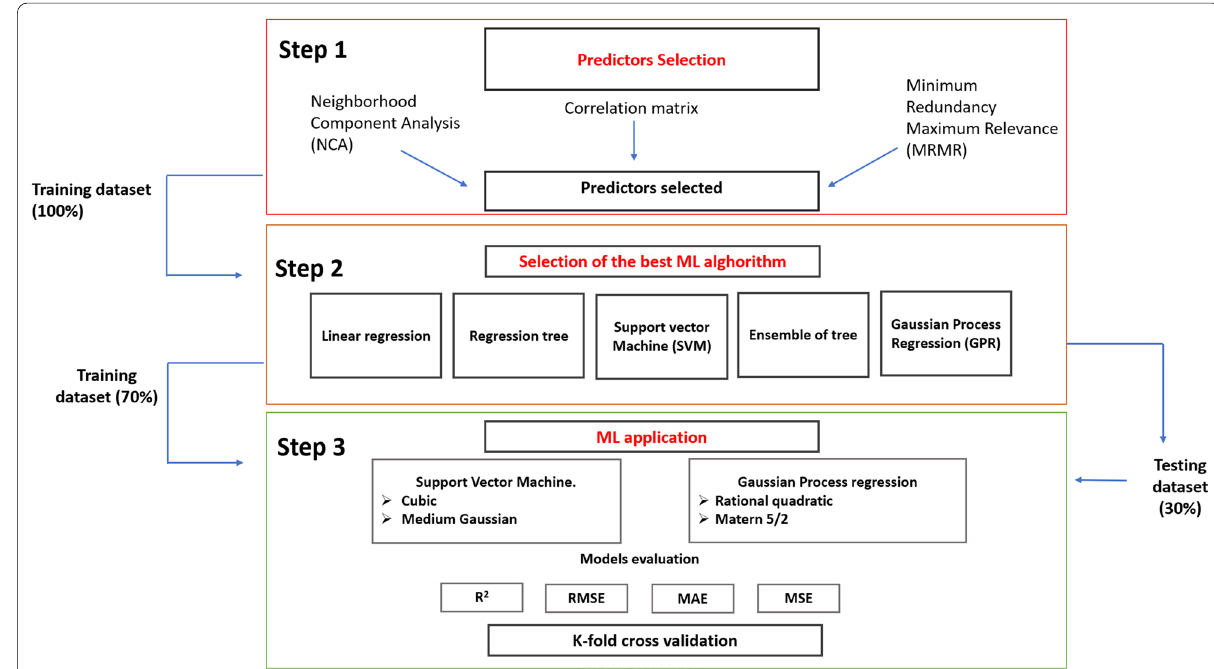
Fig. 1 Flowchart of the methodology adopted to select the predictor variables and select the ML algorithms